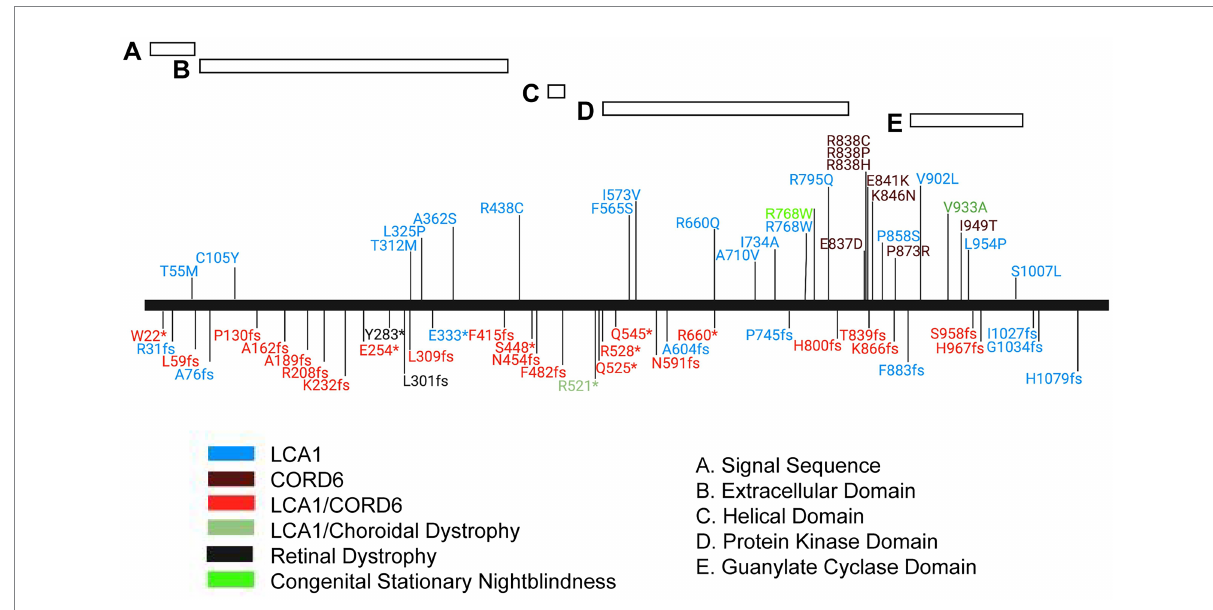
FIGURE 7 Mutation spectrum of the human GUCY2D protein. Schematic representation of the GUCY2D protein with relative position of protein domains. Alleles are localized by vertical lines and named. *, translation termination; fs, frameshift. Phenotype annotations are color coded in the allele symbol. LCA1, Leber congenital amaurosis 1, CORD6, cone-rod dystrophy